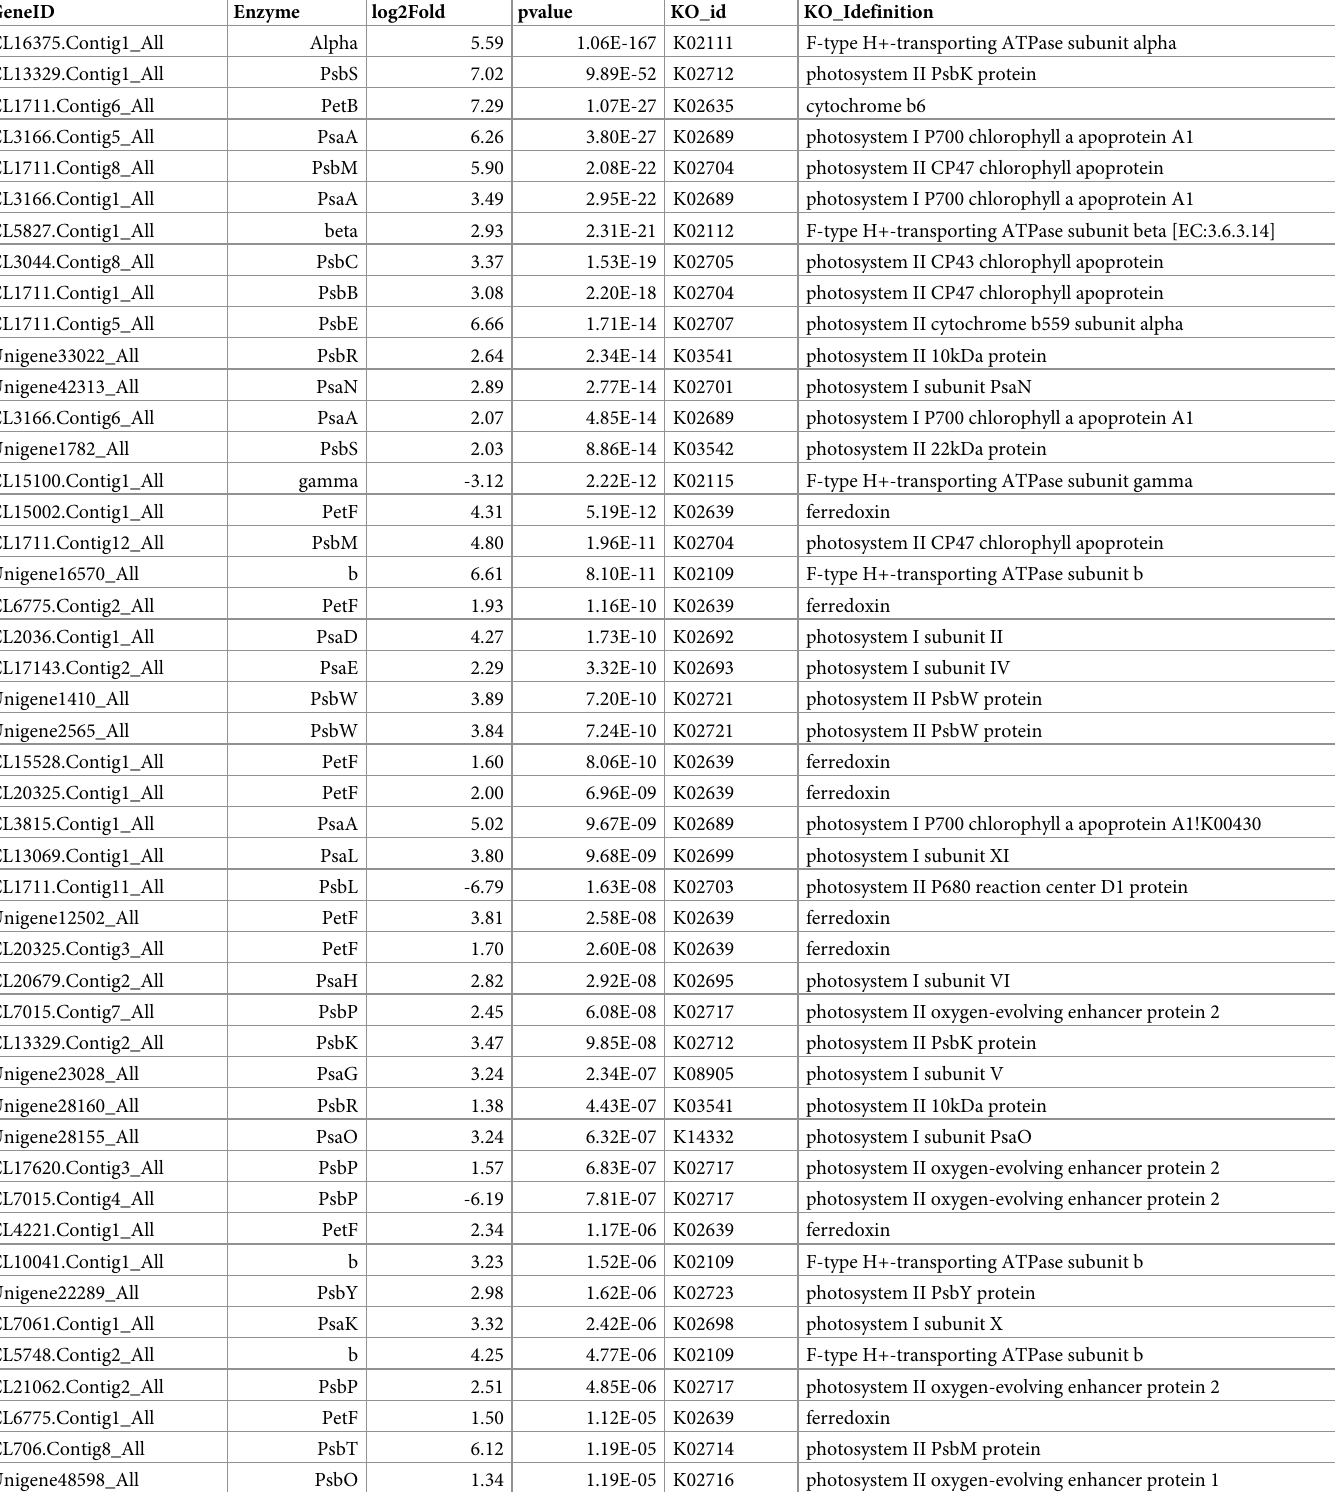
Table 1. Differentially expressed genes involved in photosynthesis